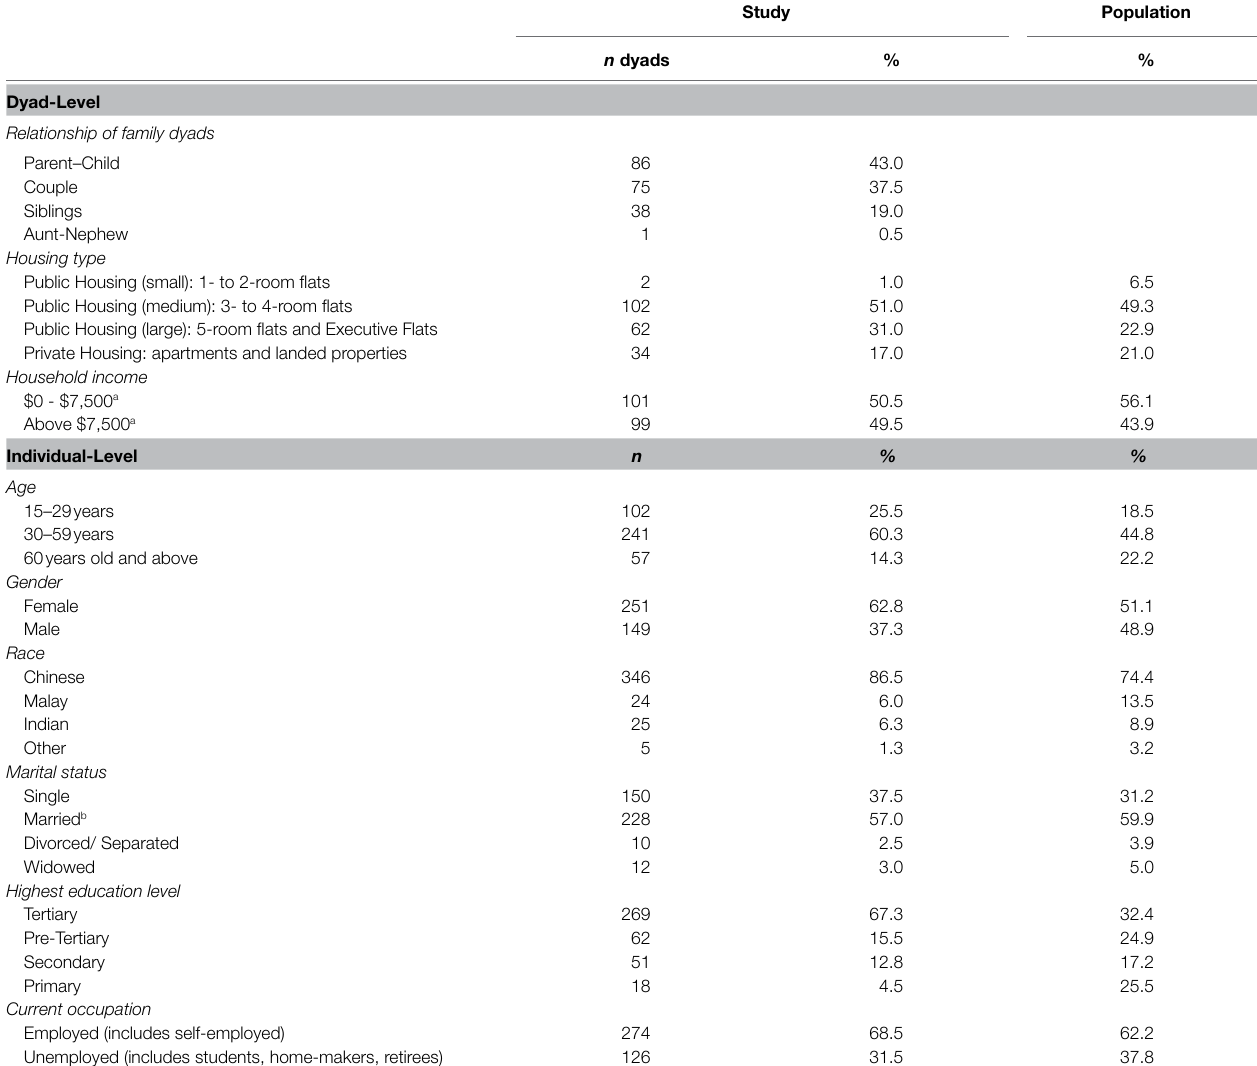
TABLE 3 | Sociodemographic characteristics of study participants vs. population